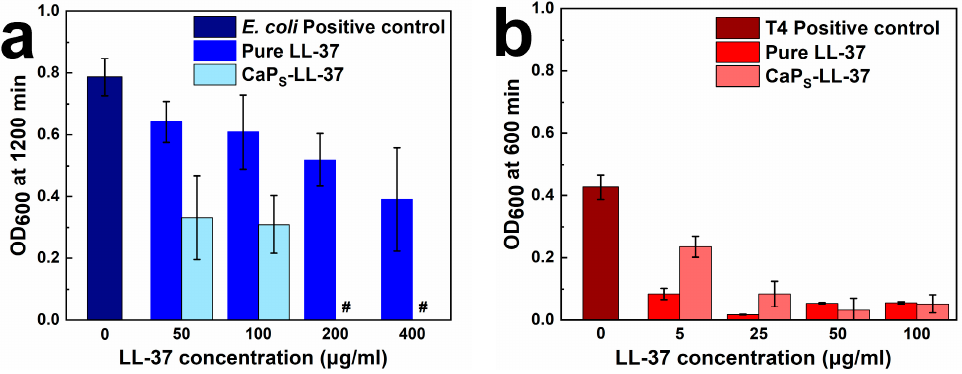
Figure 8. OD 600 values at ( a ) 1200 min for E. coli (HVM52); ( b ) 600 min for S. pneumoniae (T4) for all LL-37 concentrations tested. Measurements had been performed at least in triplicate. Mean values after subtraction of background (Figure S6) are presented. In ( a ), # denotes negative OD 600 due to background subtraction (plotted as zero in the graph for simplicity).